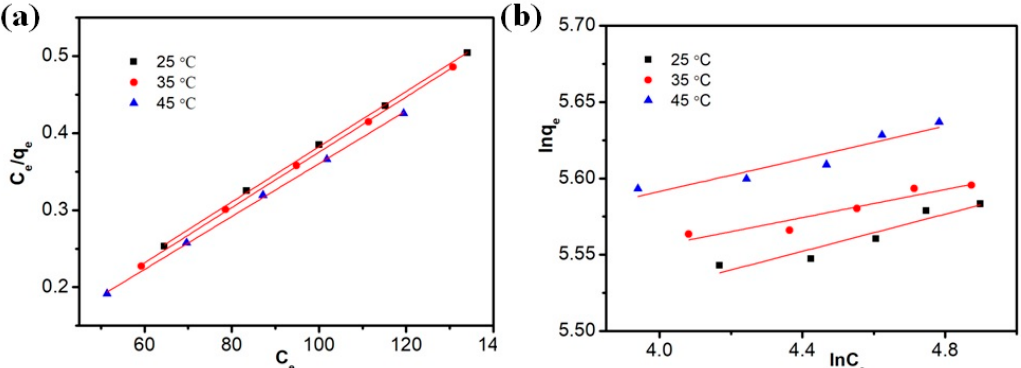
Figure 6. ( a ) Langmuir and ( b ) Freundlich isotherm for the sorption of Hg 2+ onto SG-PEI/rGH at different temperatures. Table 1. Isotherm parameter of Langmuir and Freundlich for the adsorption of Hg 2+ obtained by using linear method at different temperatures. Langmuir Torbent T (K)